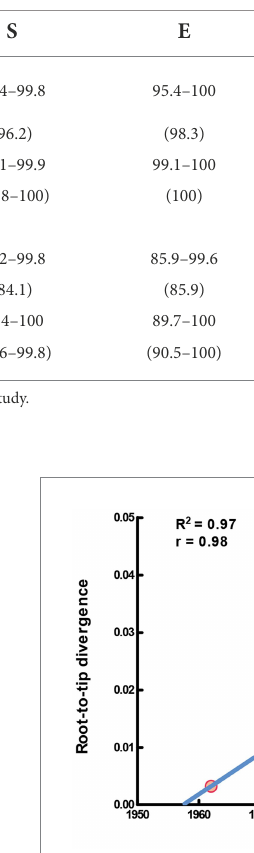
TABLE 2 Nucleotide identity of four human coronaviruses.